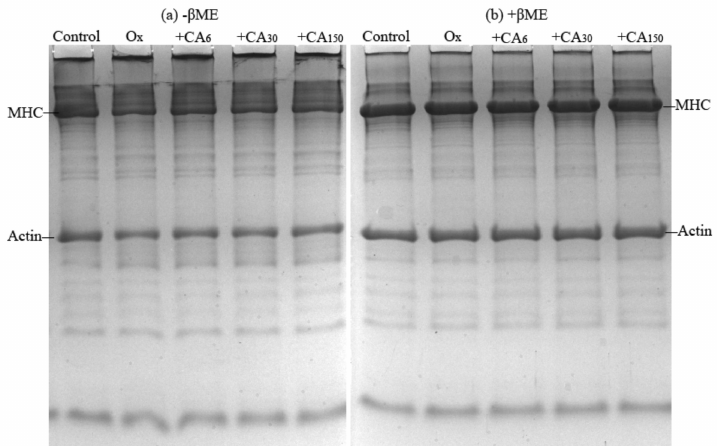
Figure 3. SDS-PAGE patterns of oxidized myofibrillar protein (MP) treated with chlorogenic acid (CA). Control: nonoxidized; Ox: oxidized; Ox + CA 6 , Ox + CA 30 , and Ox + CA 150 : oxidized in the presence of CA at 6, 30, and 150 µ M / g protein, respectively. Samples were prepared in the presence ( + β ME) or absence ( − β ME) of 10% β